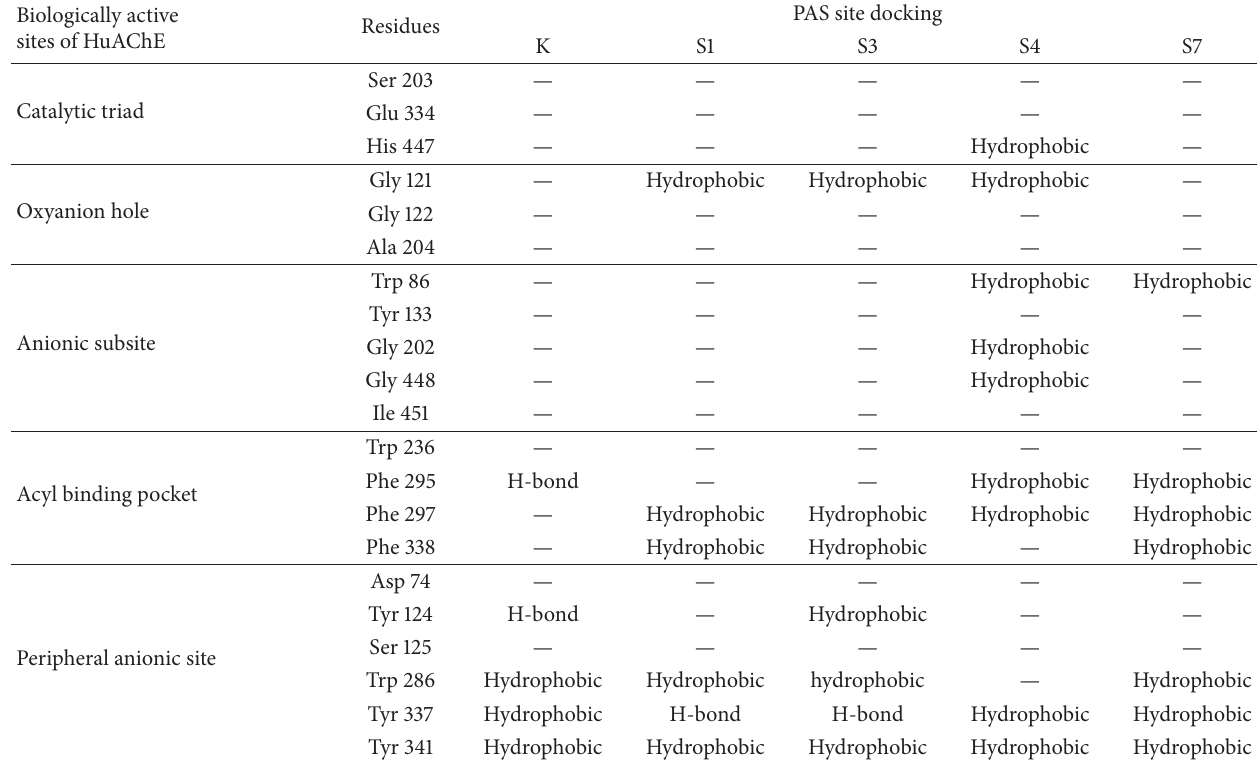
Table 5: The residues from each HuAChE active site subsites (Wiesner et al., [27]) and its interaction with derivatives at pas site docking. Biologically active sites of HuAChE